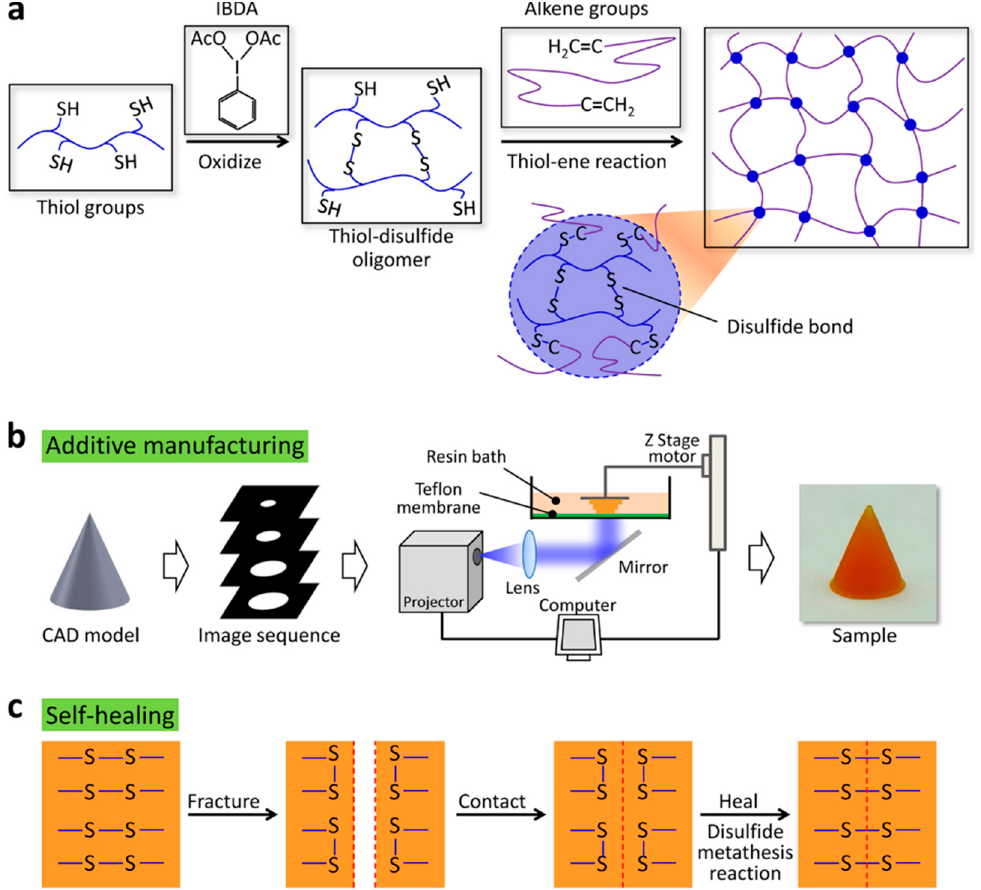
Figure 15. ( a ) The molecular design of the self-healing elastomer, where self-healing features and photo-polymerization were integrated with a self-healing elastomer based on the disulfide (R-S-S-R) and coexistence of thiol (R–S–H), through harnessing the high-rate and high yield thiol-ene crosslinking reaction to achieve the photo-polymerization. ( b ) the CAD model using image sequences to perform additive manufacturing to achieve efficient samples through radical initiation. ( c ) the process further goes into self-healing by harnessing dynamic disulfide bonds through reactions (disulfide) to bridge the fractured interface, as shown. The experiment was conducted with high efficient oxidant, iodobenzene diacetate (IBDA). (Reprinted with permission from [61]. Copyright NPG Asia Materials and creative commons, 2019).